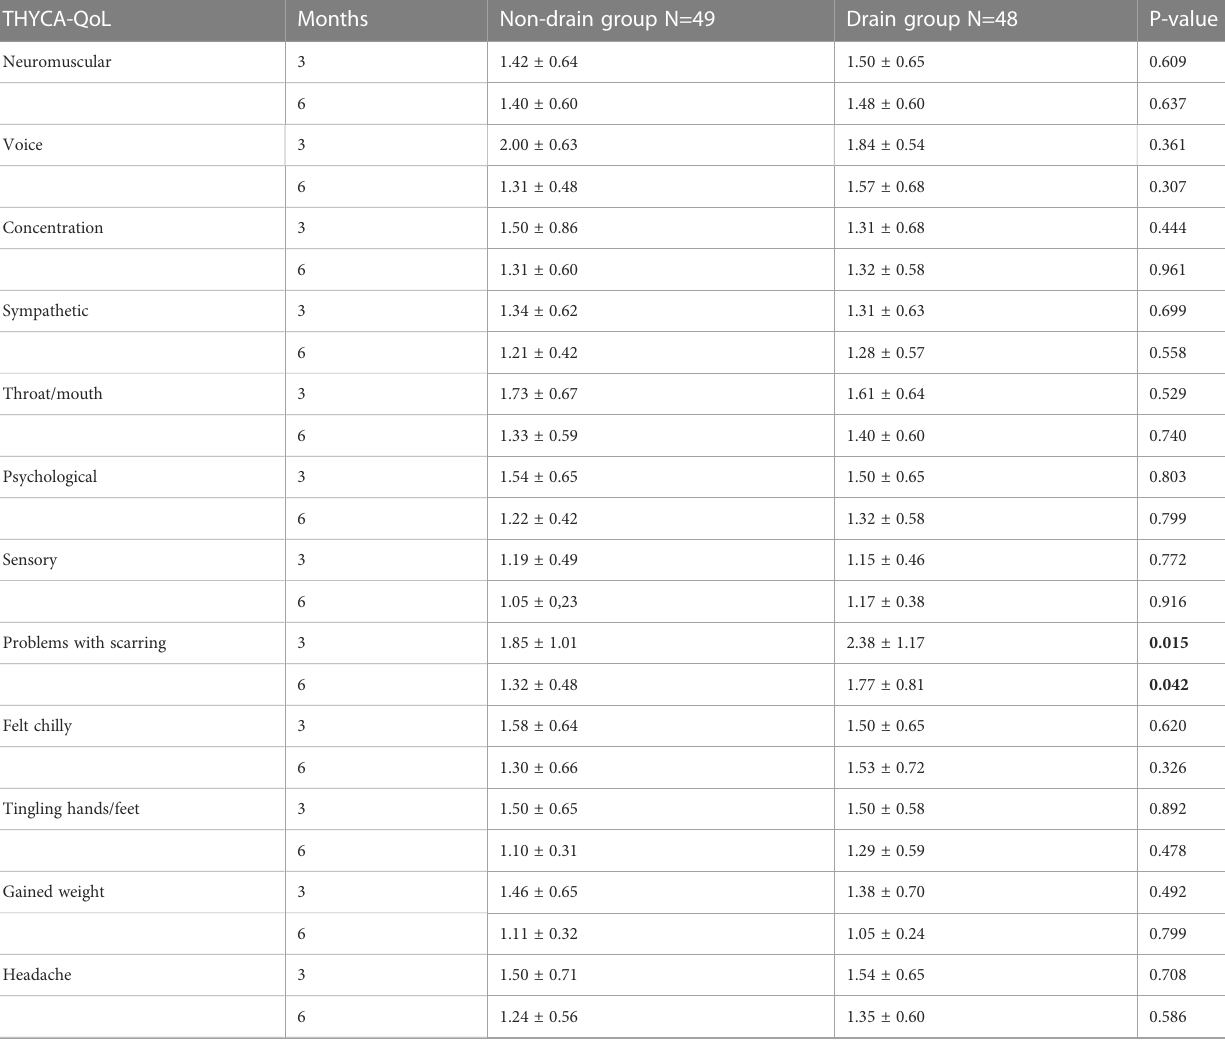
TABLE 5 Comparison of THYCA-QOL between the non-drainage group and drainage